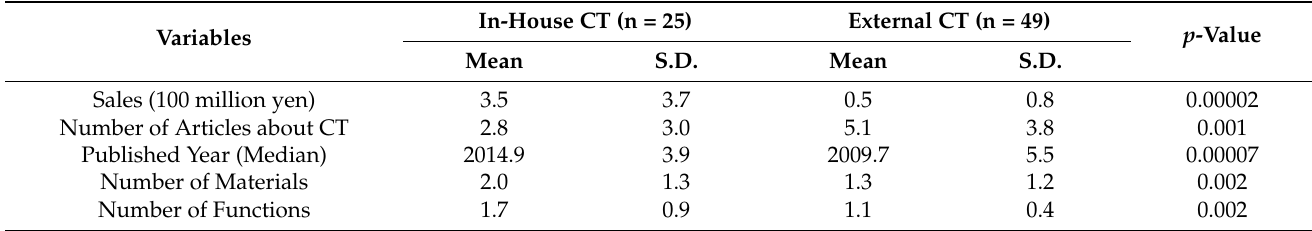
Table 6. Inter-group testing between in-house and external test types (sales, number of clinical trials (CT) papers, year of publication, number of materials, number of functions).